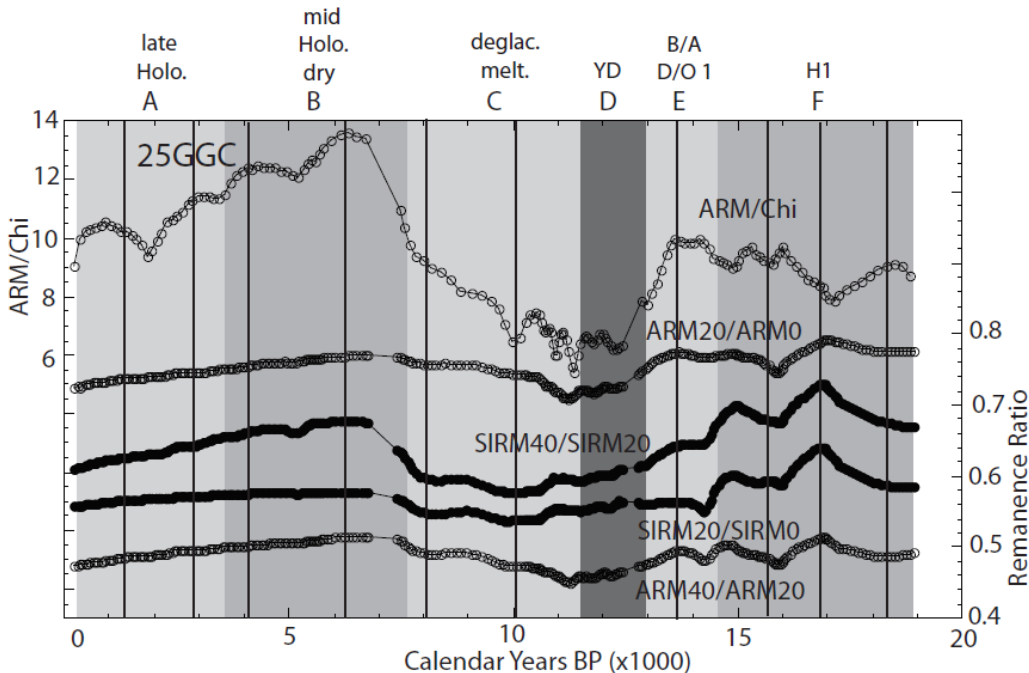
Figure 9. Rock magnetic coercivity variability for core 25GGC versus time. Alternating light and dark grey zones are multi-millennial-scale oscillations in magnetic coercivity (light = lower coercivity or coarser-grained; dark = higher coercivity or finer-grained) labeled A–I. Vertical lines indicate finer-scale millennial intensity peaks in Figures 6 and 7. There is no significant evidence for coercivity variations associated with those intensity